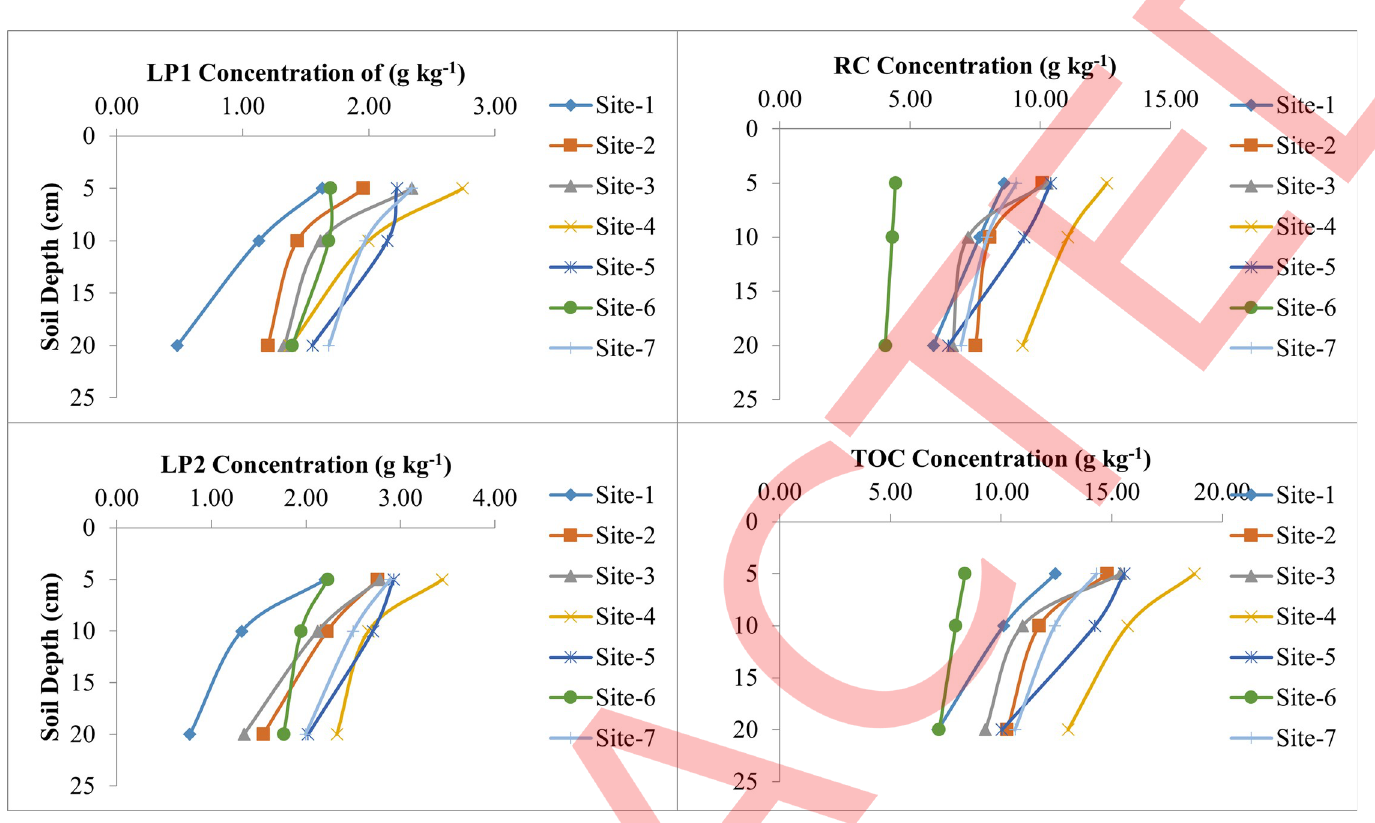
Fig 1. Depth wise distribution of LP-1, LP-2, RC, and TOC in different sites of Coochbehar and Malda.